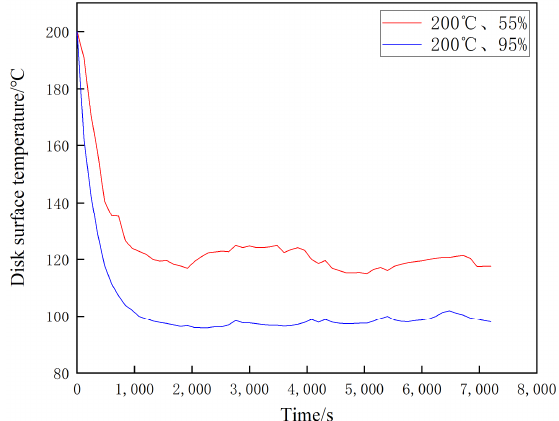
◦ C under different ambient